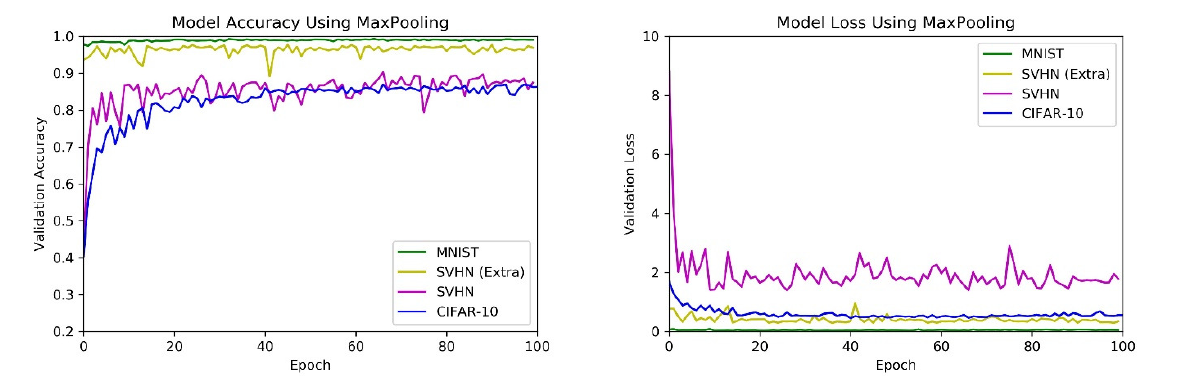
FIG. 8: ACCURACIES AND LOSSES OF ALL THE 4 DATA SETS